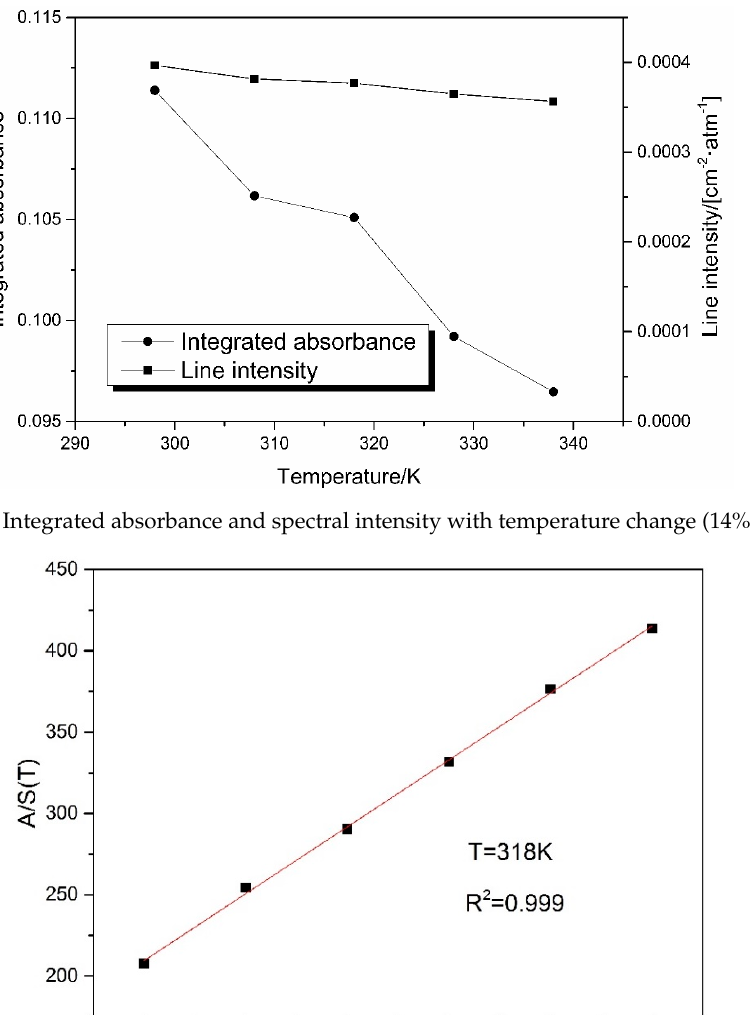
Figure 8. Integrated absorbance and spectral intensity with temperature change (14% CO 2 ). Figure 9. A linear fit between A/S(T) and concentration at T = 318 K. Figure 9. A linear fit between A / S ( T ) and concentration at T = 318